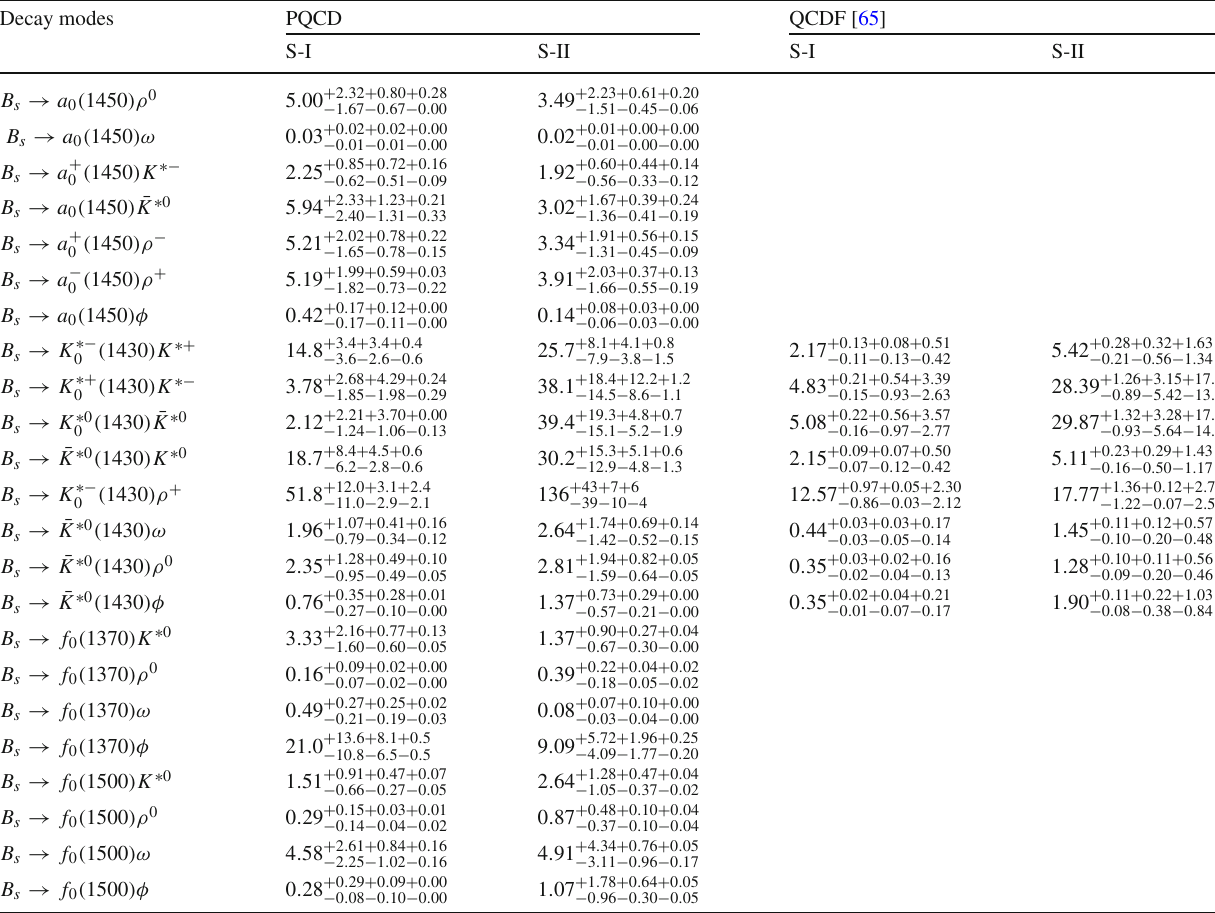
Table 3 The CP averaged branching fractions (in 10 − 6 ) of the B s → SV decays involving the heavier scalar mesons in S-I and S-II Decay